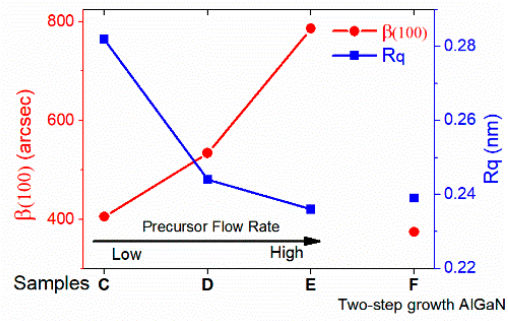
Figure 5. The relationship between precursor flow rate and AlGaN crystalline qualities.